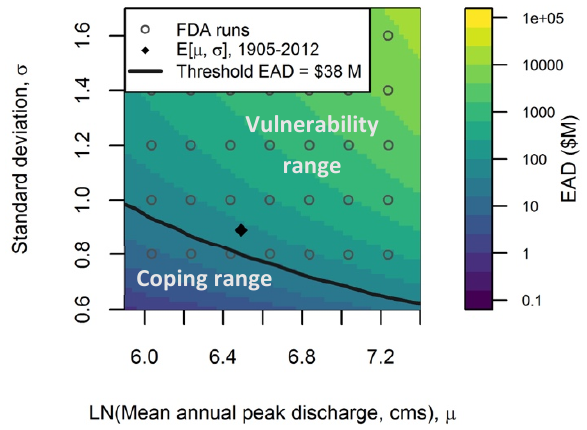
Figure 5. Gridded FDA model runs (open circles) used in the regression model to develop the flood risk response surface, LN(EAD) = ƒ(μ, σ), under Without Project conditions (shaded background). The black diamond indicates the EAD based on historic data from 1905–2012. The system is vulnerable to flood regimes above the white threshold line where EAD = $38M.